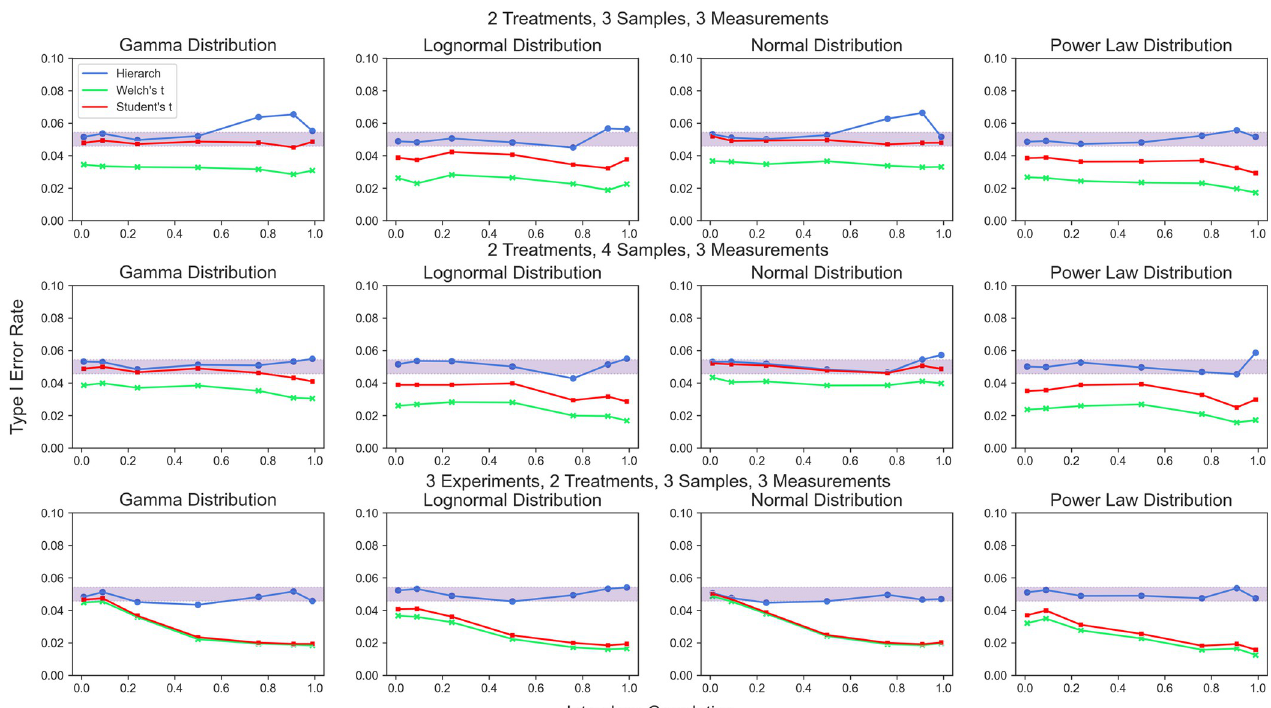
Fig 9. Type I error rate for hierarchical randomization test based on the t statistic compared to Student’s t test and Welch’s t test. Both treatment groups have equal variance. Shaded area represents the 95% binomial confidence interval around a 5% type I error rate.